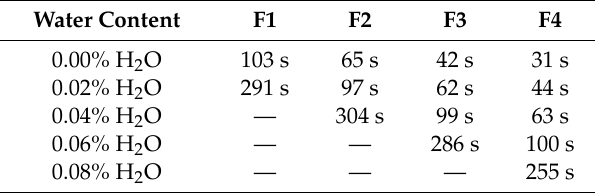
Figure 8. Influence of water on the temperature curves of ( a ) formulation F1, ( b ) formulation F2, ( c ) formulation F3, ( d ) formulation F4. Table 3. Measured curing times for formulations F1–F4 at di ff erent amounts of